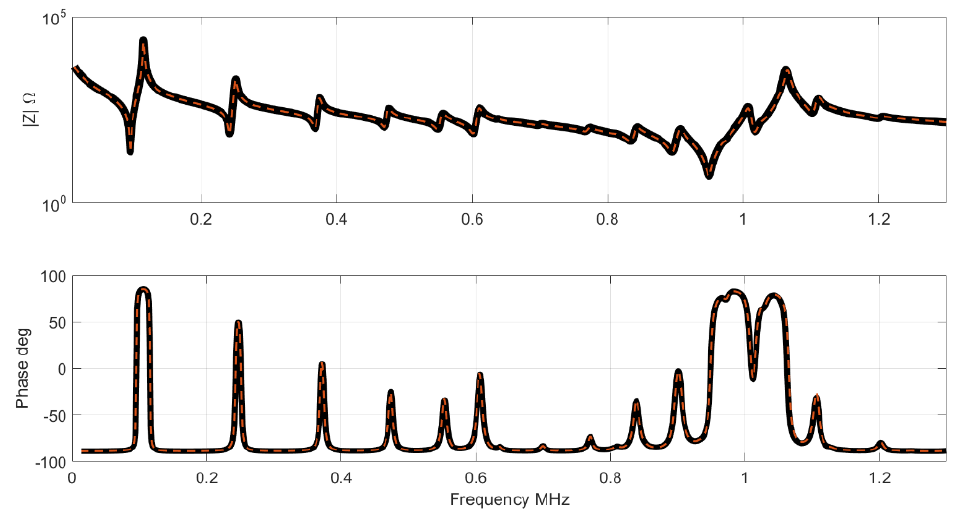
Figure 5. Impedance results. The black curve is the impedance of the Test set, the red curve is the NN result.